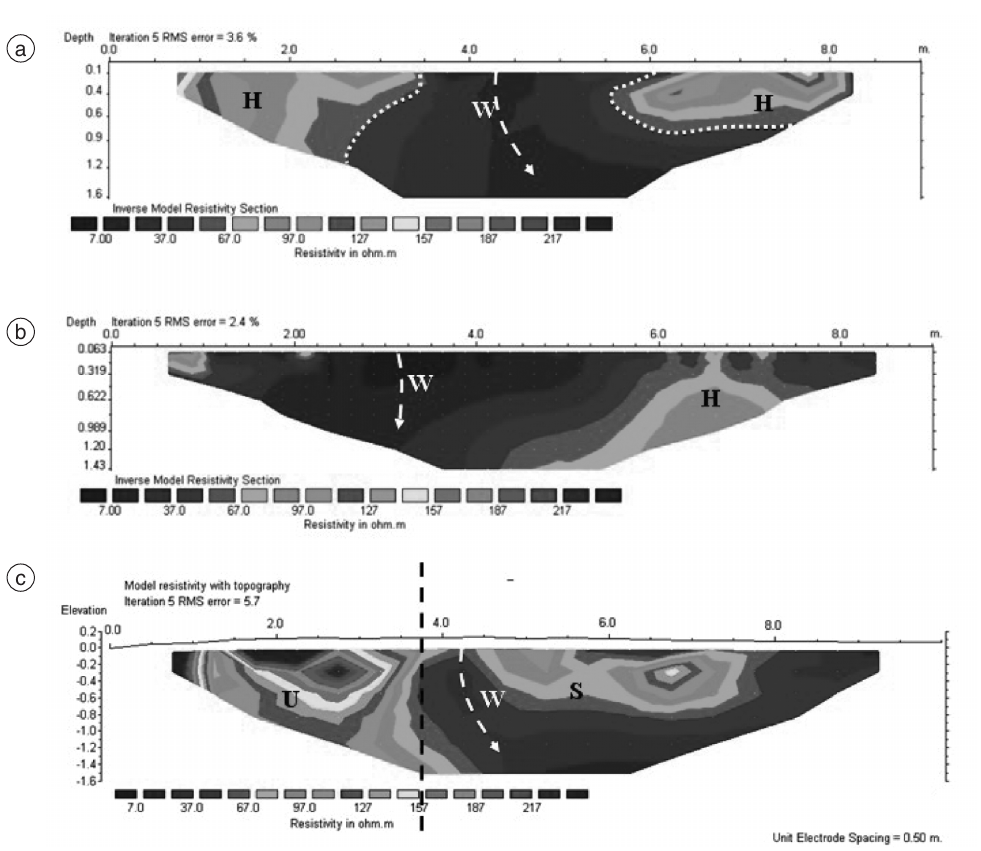
Fig. 6a-c. ERT models relating to profiles G2 (a), G3 (b) and G4